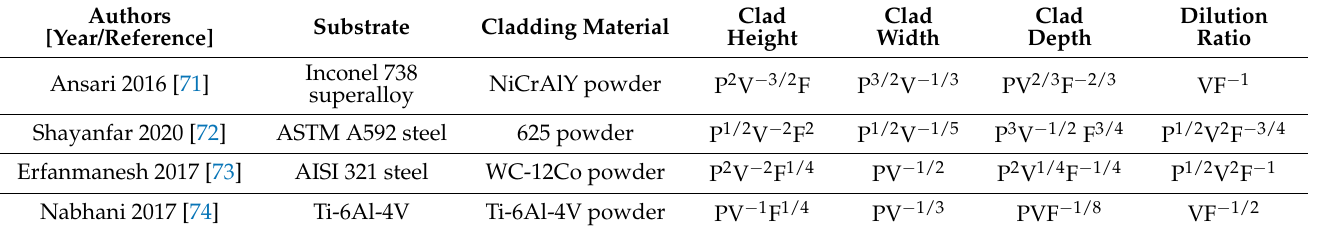
Table 1. A combination of process parameters that have an impact on cladding results.